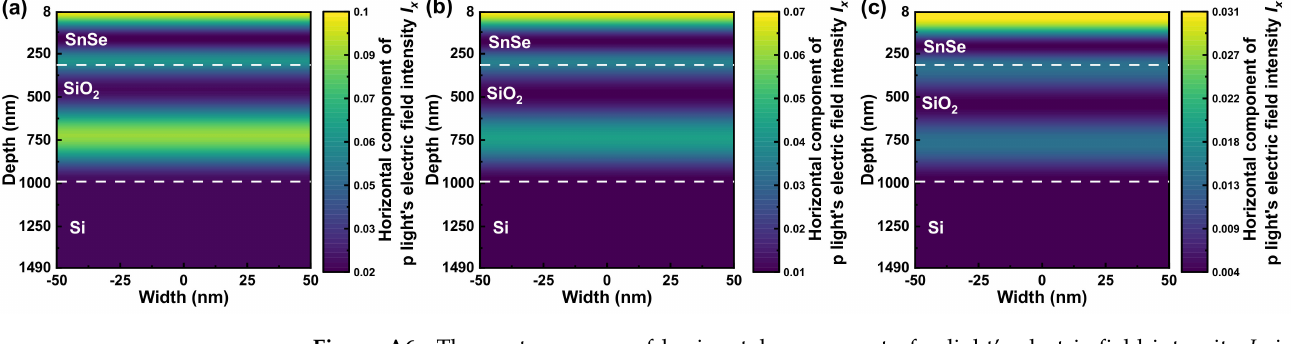
Figure A6. The contour maps of horizontal component of p light’s electric field intensity I x in SnSe ( d SnSe = 315 nm)-SiO 2 ( d SiO = 675 nm)-Si multilayer structure at the incident angle of ( a ) 70 ◦ , 2 ( b ) 75 ◦ , and ( c ) 80 ◦ at the corresponding ER max wavelength for incident-angle-modulation near- infrared